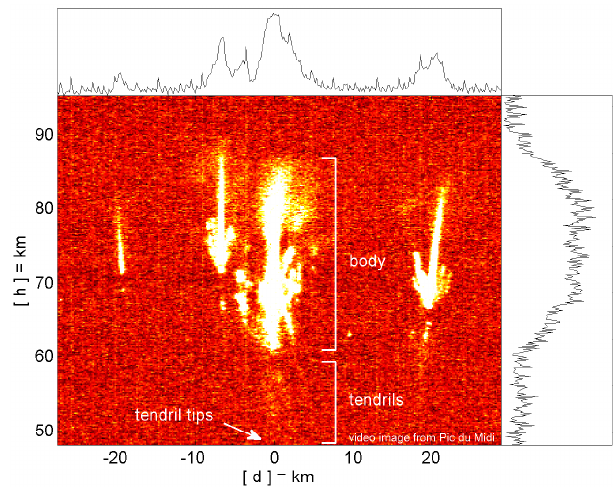
Fig. 2. The main body of the sprite extends upwards from ∼ 60–85km height and the tendrils of the sprite extend downwards from ∼ 60–50km as triangulated by use of two video cameras from Pic du Midi in the French Pyr´en´ees (42.9 ◦ N, 0.1 ◦ E) and Sant Vicenc¸ de Castellet in North-Eastern Spain (41.7 ◦ N, 1.9 ◦ E). The sprite body is surrounded by three columniform sprites at distances up to ∼ 20km. The panels on the top and right hand side indicate the relative luminosity of the sprite which is inferred from the intensity of the image pixels.